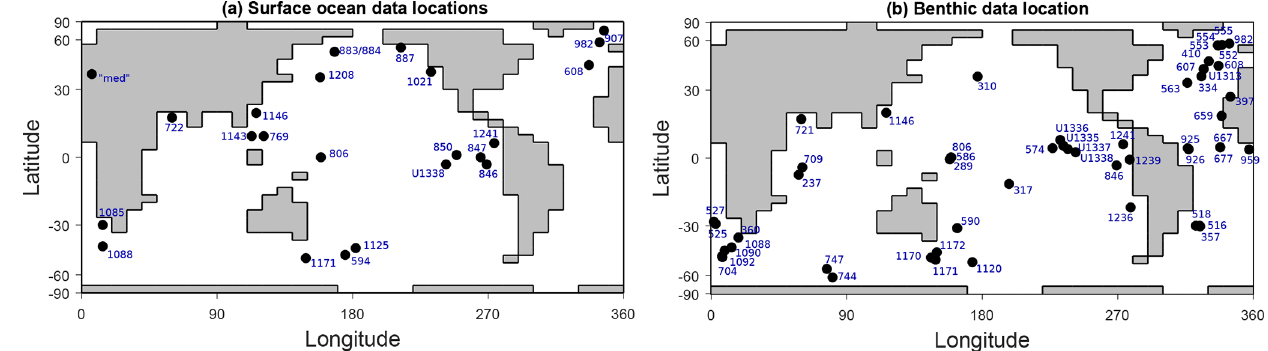
Figure 1. Present-day location of surface ocean temperature data points (a) and benthic δ 18 O and δ 13 C data points (b) collated for this study (the Holocene δ 13 C data set from Peterson et al., 2014, is not